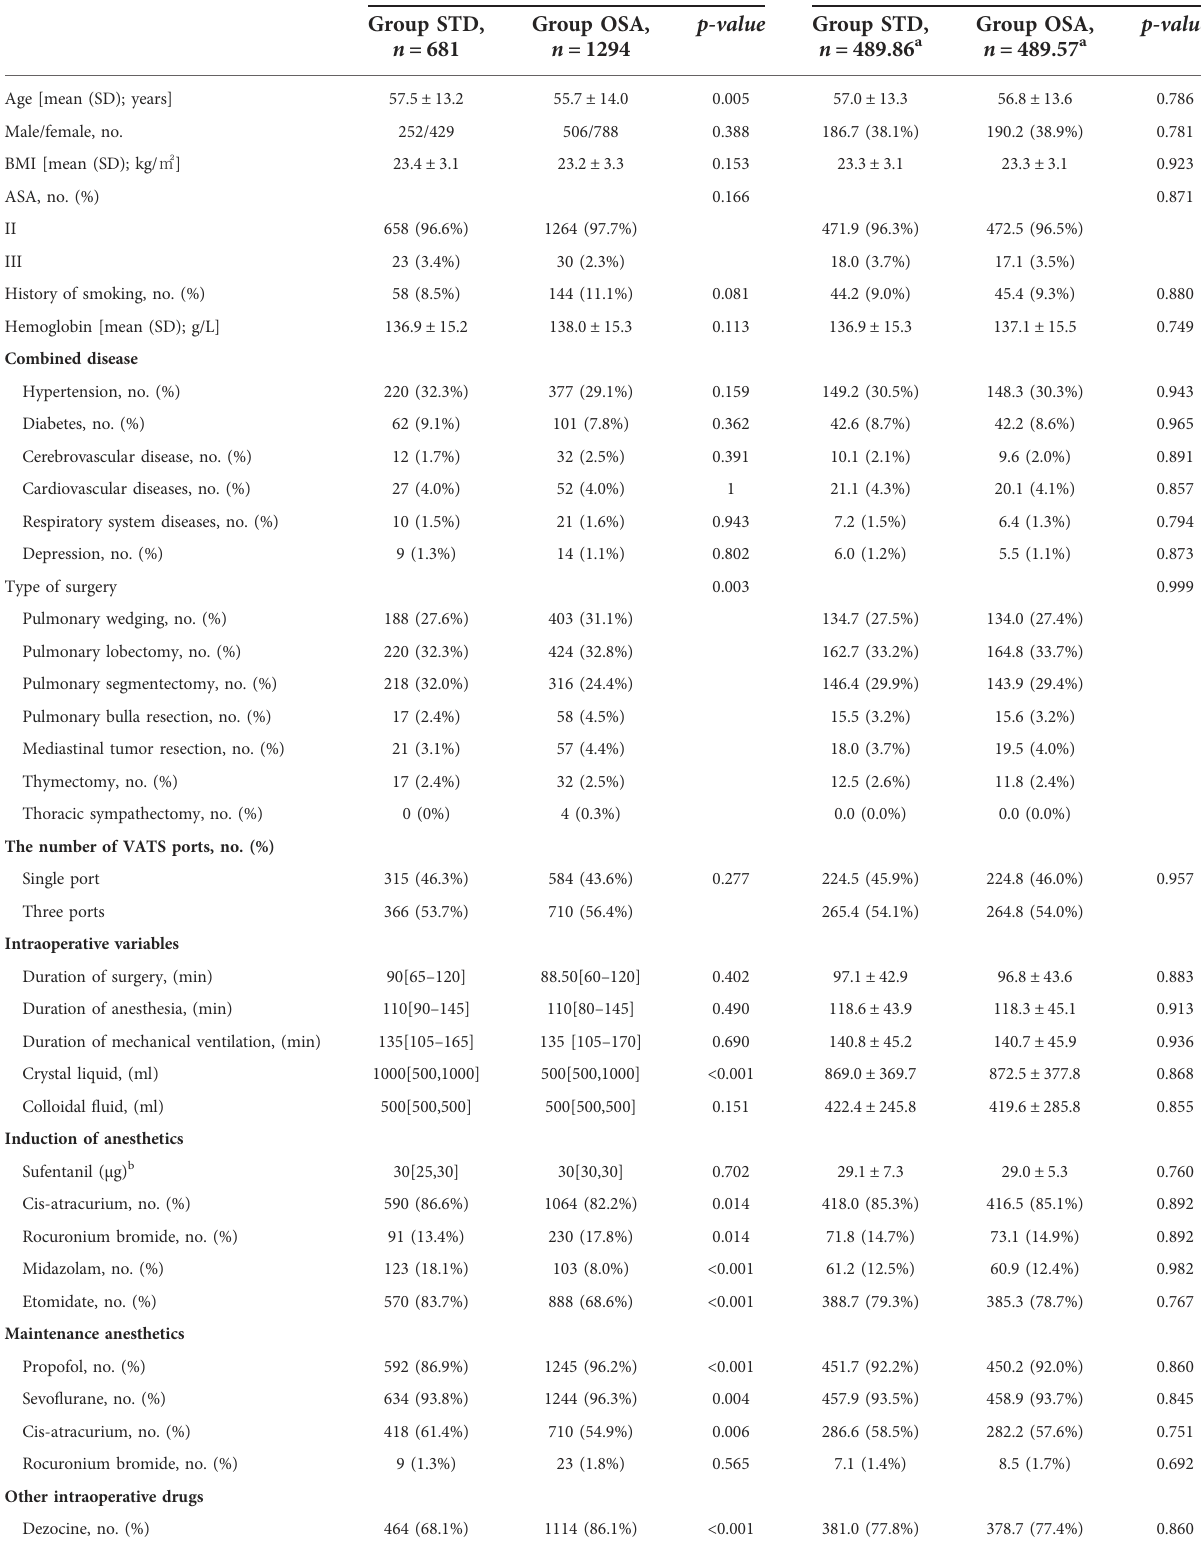
TABLE 1 Demographic and clinical characteristics of the two groups before and after propensity score